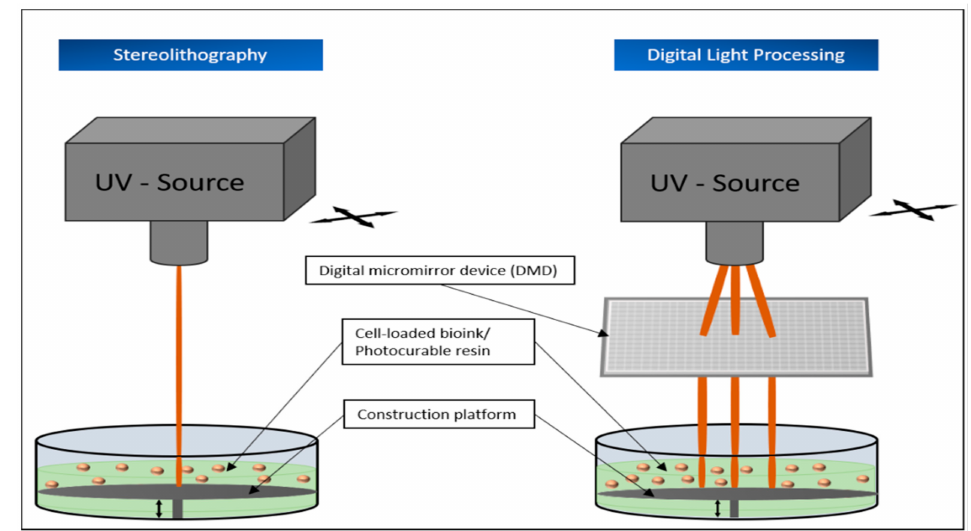
Figure 3. Schematic representation of stereolithography (SLA) and digital light processing (DPL) as top-down approaches. Both processes are based on crosslinking a photosensitive resin using a laser. SLA cures the individual points of a resin layer one after the other. Digital light processing can cure entire layers at once, using so-called digital micromirror